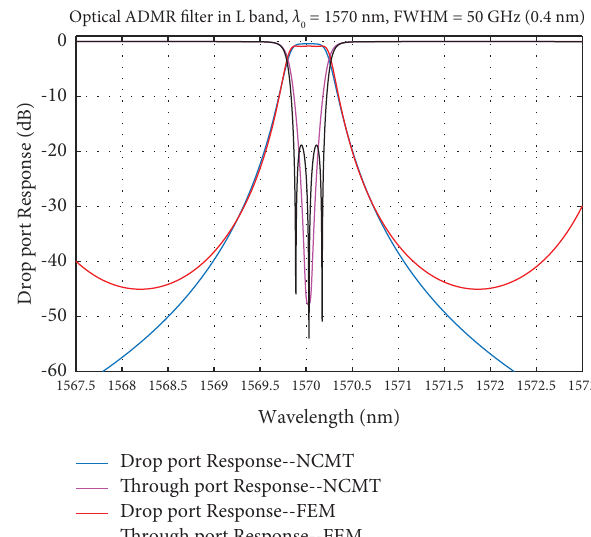
Figure 7: Simulation of the flter responses at through and drop ports using NCMT are plotted together with the S-parameters simulation results given by FEM. T � 298 K in the TE mode (TM mode giving practically the same profle). Full wave at half maximum (FWHM) � 50GHz (0.4nm) around the resonance wavelength of 1570nm with FSR � 3.7 nm, Q � 2584, fnesse � 19, and an extinction ratio (ER) � 60dB.